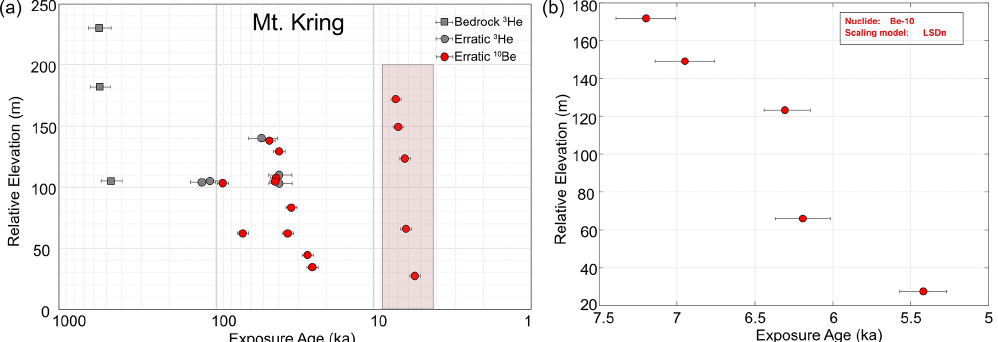
Figure 4. Relative elevation, above the ice, vs. calculated surface exposure ages for Mt Kring. (a) All exposure ages. Erratics plotted as circles, bedrock as squares( 10 Be, red, and 3 He, grey). Errors bars show total uncertainty. Panel (b) shows only Holocene